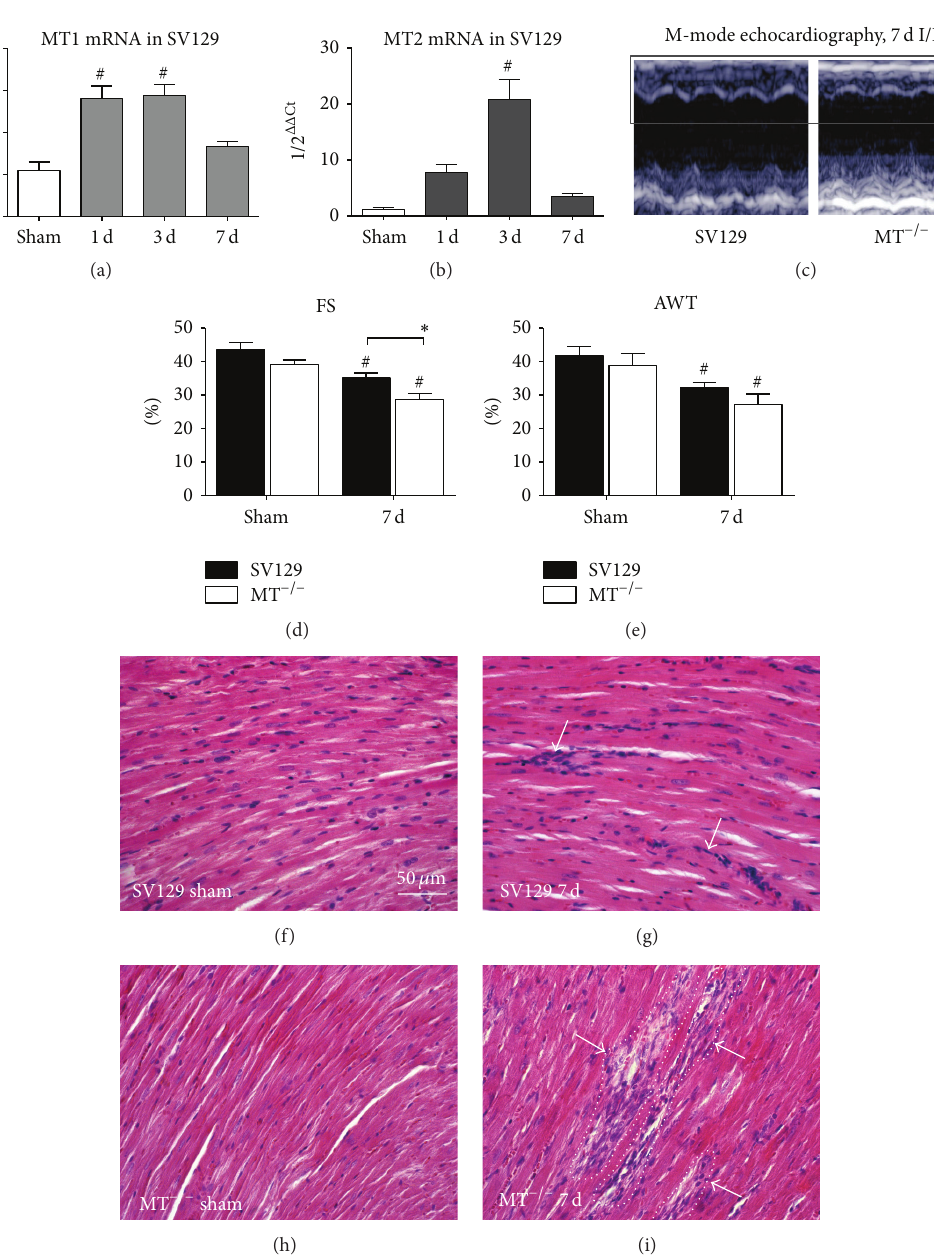
Figure 1: MT1-/2-deficiency leads to cardiomyocyte loss and deterioration of left ventricular function. The mRNA of (a) MT1 and (b) MT2 is upregulated after 1, 3, and 7 days (d) I / R in SV129 WT-mice. (c) Representative short axis M-mode echocardiographs from WT- and MT −/− -mice after 7 days of (d) I / R. (d) and (e) reveal worse left ventricular function of MT −/− -mice after 7 days of I / R compared to the WT. Representative HE-stainings reveal no cellular infiltration in both sham groups (f and h), but interstitial cellular infiltrates (arrows) into WT- hearts after 7days of I / R (g), in contrast to microinfarcted areas with loss of cardiomyocytes (dotted line) and cellular infiltration (arrows) in MT 1 −/− -mice at the same time (h and i). 𝑛 = 8–10/group; scale bar in (f)–(i): 50 𝜇 m; RT-qPCR using Taqman (cid:2) , mRNA expression is related to shams and GAPDH using comparative ΔΔ Ct-method; ∗ indicates P ≤ 0.05 between the genotypes; # indicates P ≤ 0.05 versus respective